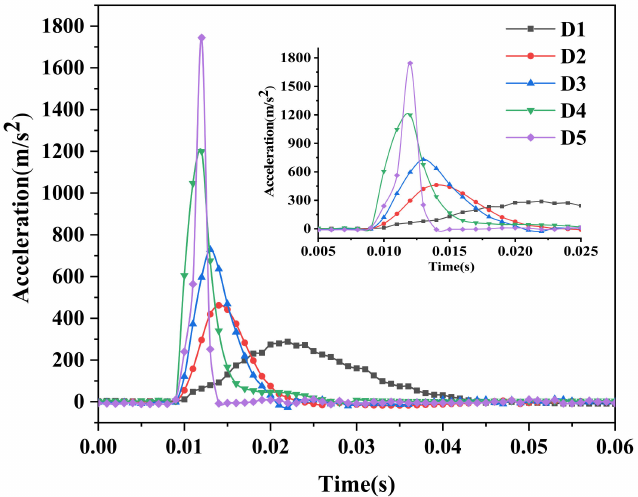
Figure 3. Acceleration time history curves of drop hammers with different shapes impacting the sand